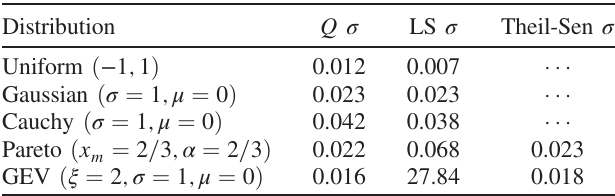
TABLE II. Comparison of the standard error for a linear trend with unit rise in 64 years in the following: Q , bisquare-weighted robust least squares estimator and, for the two most challenging cases, the Theil-Sen algorithm ( 10 3 trials). The GEV result for the bisquare least squares has numerous severe outliers for slope estimates. Similarly, for the slightly modified form x exp ð − x Þ with GEV noise, the bisquare least squares method yields 2 . 82 (cid:2) 2 . 81 , Q gives 1 . 003 (cid:2) 0 . 047 , and the Theil-Sen estimator is